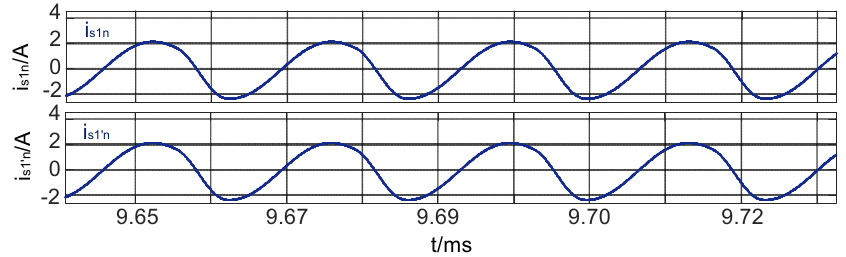
Figure 11. The input current waveform of the IDC parallel resonance circuit in static mode . Figure 10. The input current waveform of traditional parallel resonance circuit in static mode .